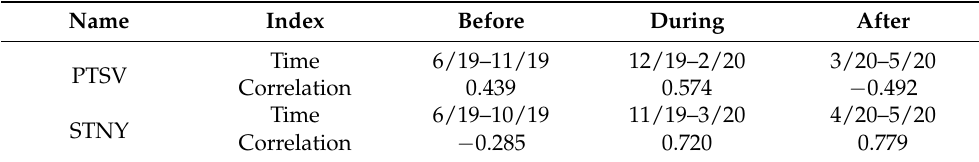
Table 5. Correlation coefficient statistics between the 15-day moving STD time series of ∆ PWV and PM10 at PTSV and STNY. The format of Time is: